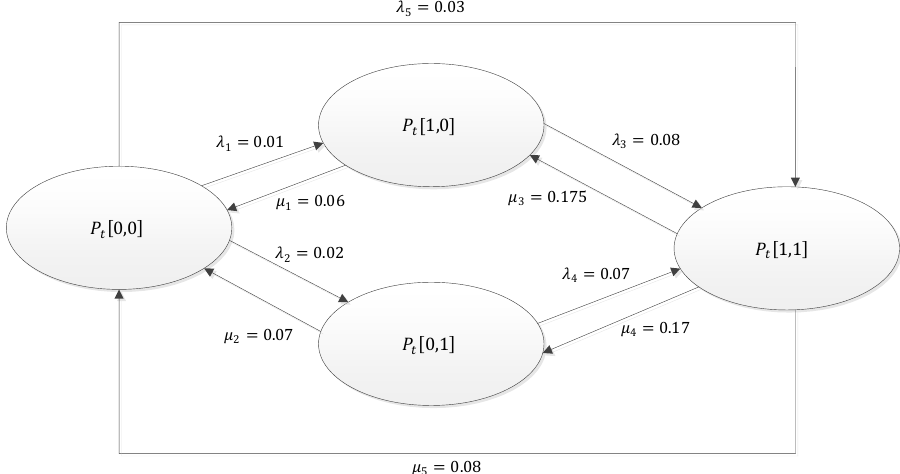
Figure 7. Reliability model of a communication system with a single standby device. Description of probability is shown in Figure 7: